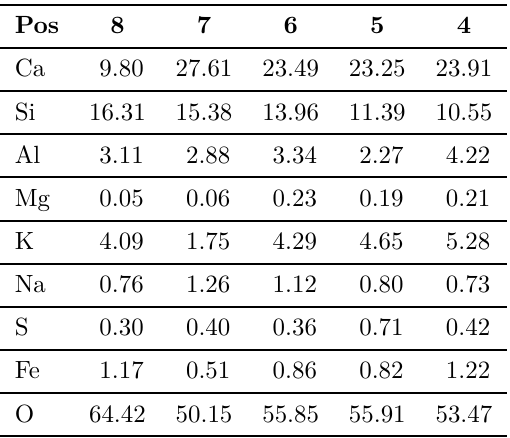
Table 3. EPMA – EDX chemical elements analysis (weight percentage containment in %).